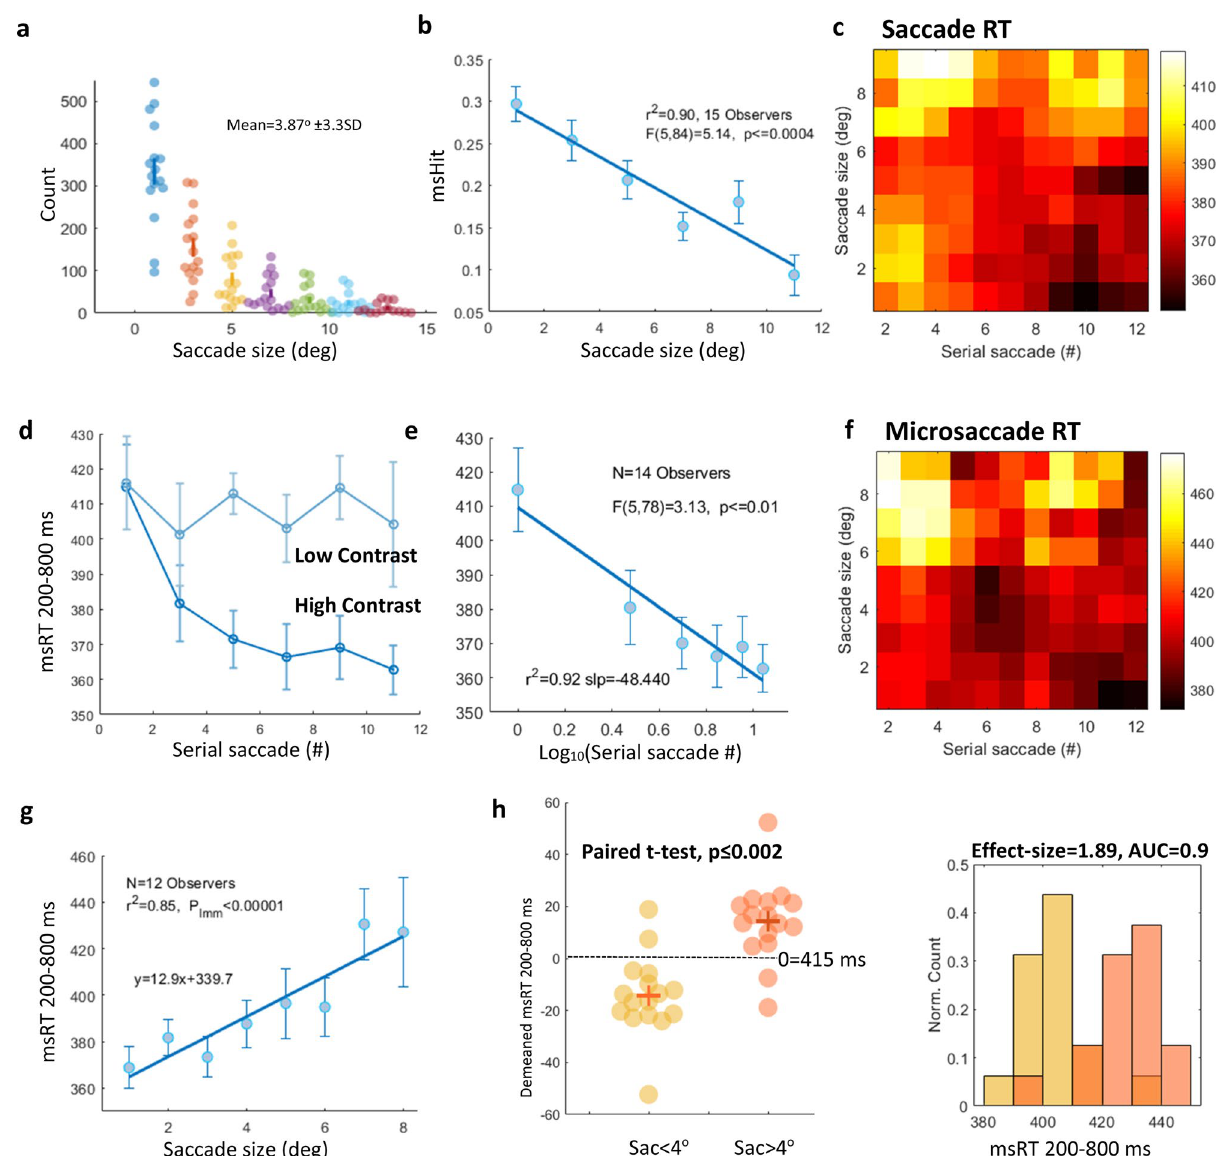
Figure 3. The results for experiment 1: Facilitation over repeated saccades and the saccade size. ( a ) A saccade size histogram with a dot per participant. ( b ) The microsaccade hit rate (msHit) as a function of saccade size (deg), the significance assessed using One-way Anova, F(5,84) = 5.14, p ≤ 0.0004. ( c ) 2D smoothed (see the “Methods” section) fixation-related sacRT (MS-free fixations); all conditions combined as a function of the serial saccade number over time (X-axes) and the saccade size (Y-axes). Light and dark colors represent longer and shorter RTs, respectively. ( d ) Fixation-related msRT as a function of the serial saccade number for high (dark blue) and low contrast, with error bars denoting 1SE computed on the demeaned data, n = 14 (see the “Methods” section). ( e ) msRT as a function of Log contrast only for significance assessment using LMM (see the “Methods” section), p ≤ 0.001. ( f ) The same as c for msRT. ( g ) Fixation-related msRT under all conditions as a function of saccade size (deg) with LMM assessment yielding significance, slope = 12.95, t(94) = 4.8, p ≤ 0.00001 with CI (7.6, 18.3). ( h ) A comparison between msRT in trials triggered by small saccades (< 4°) and large saccades (> 4°), p ≤ 0.002, paired t-test (left panel). msRT histogram comparisons for small and large saccades, showing a very large effect size (1.89 Cohen’s d) and AUC = 0.9 (the right